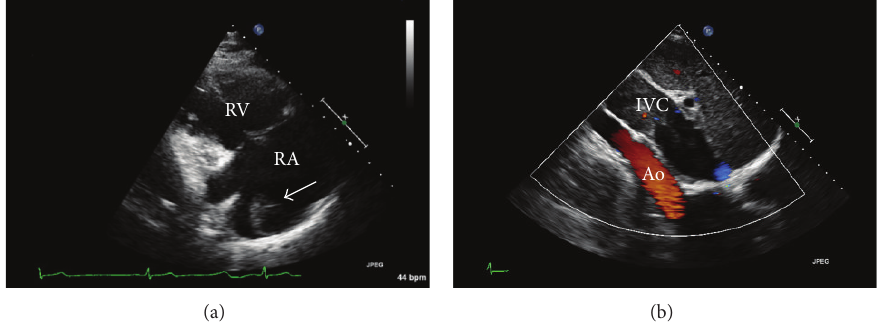
Figure 1: (a) Transthoracic echo showing right atrial mass (arrow). (b) Doppler flow showing IVC tumor restricting blood flow.